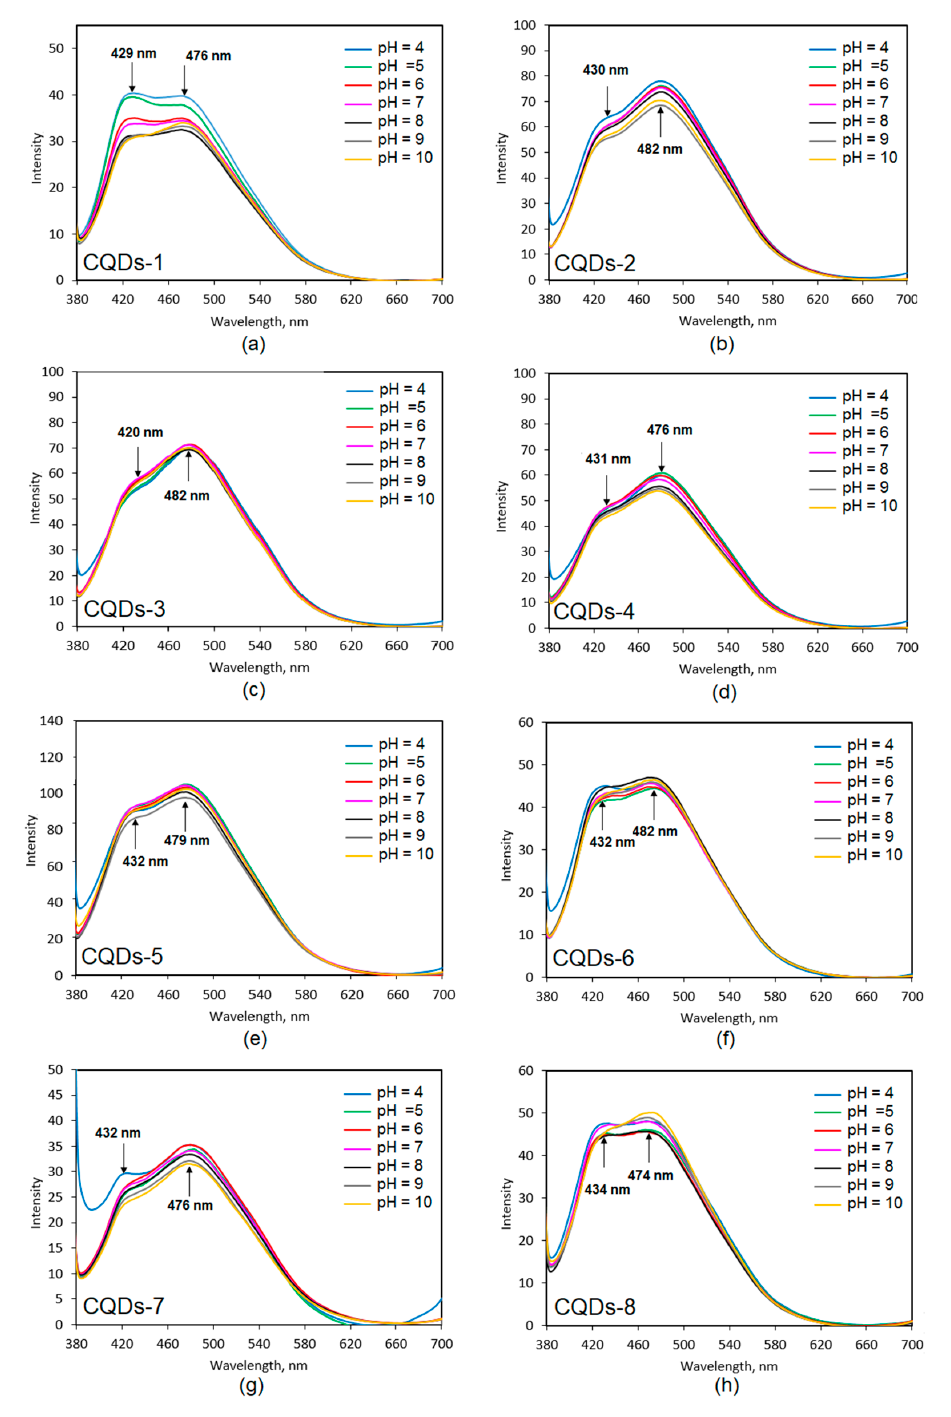
Figure 9. Fluorescence dependence on pH of the prepared samples: ( a )—CQDs-1; ( b )—CQDs-2; ( c )—CQDs-3; ( d )—CQDs-4; ( e )—CQDs-5; ( f )—CQDs-6; ( g )—CQDs-7 and ( h )—CQDs-8.